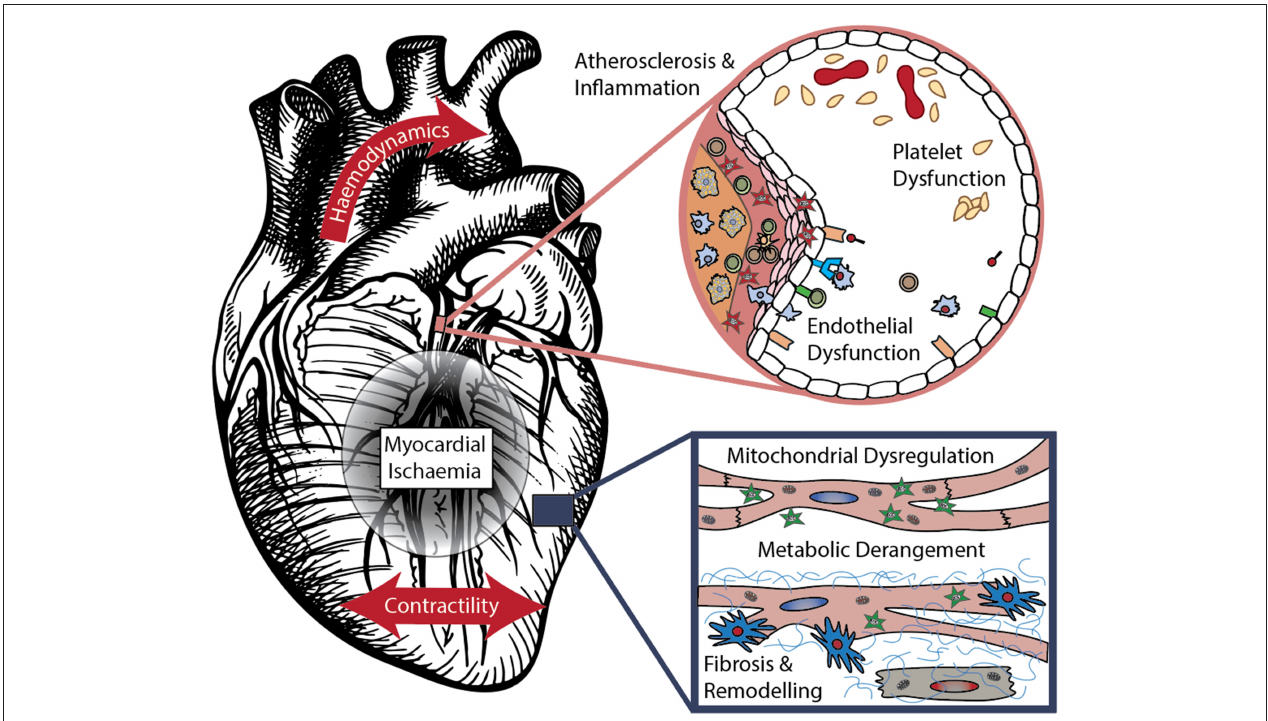
FIGURE 1 | Mechanisms of cardiovascular disease – components modified from (10) with